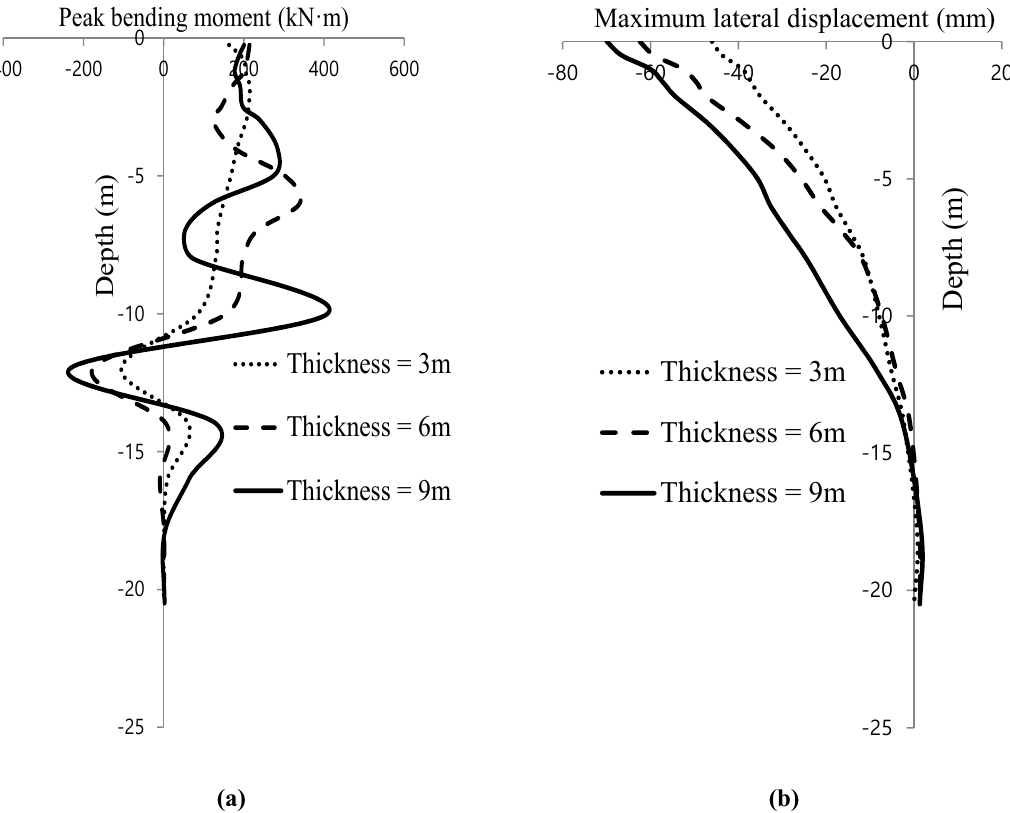
Figure 12. Dynamic pile response envelopes according to the thickness of liquefiable layer: ( a ) Peak bending moment along the depth, ( b ) Maximum lateral displacement along the depth